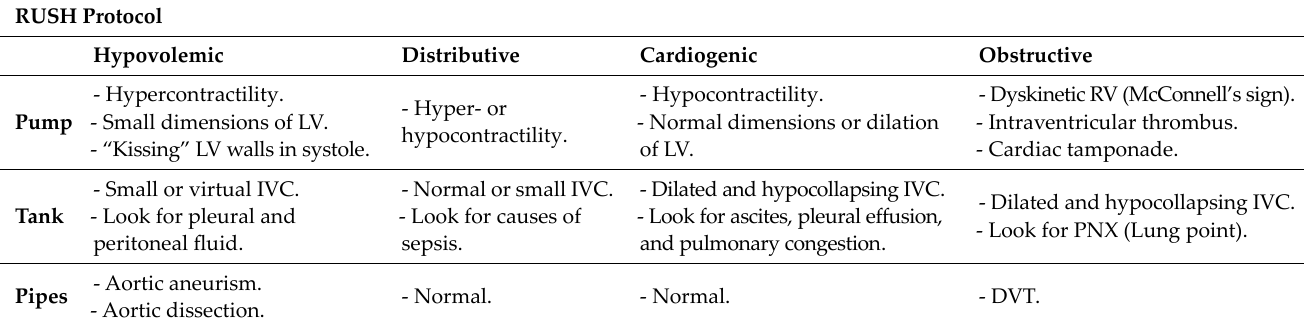
Table 2. RUSH protocol. Echography finding in different types of shock